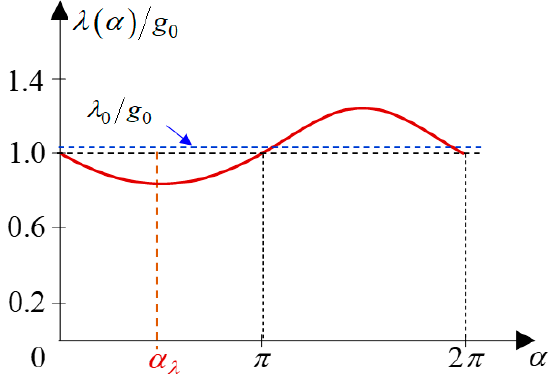
Figure 3. Air gap permeance referred to g 0 ; case ε = 0.25; α λ = π /2.